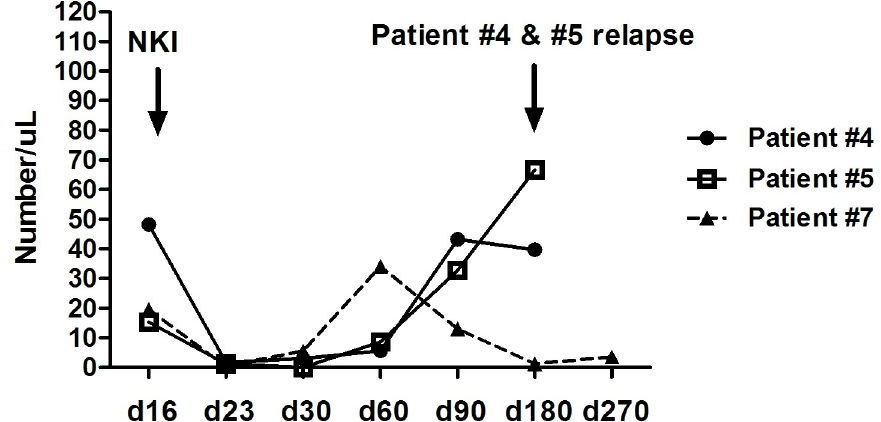
Fig 3. Changes in granulocyte-derived MDSCs after NKI following haplo-SCT. The number of granulocyte-derived MDSCs decreased after NKI. In two patients (patient #3 and #4), the number of granulocyte-derived MDSCs increased from day 90 and tumor relapse/progression had occurred at the six-month tumor evaluation. On the other hand, the number of granulocyte-derived MDSCs did not increase in patient #7, who remained progression-free.